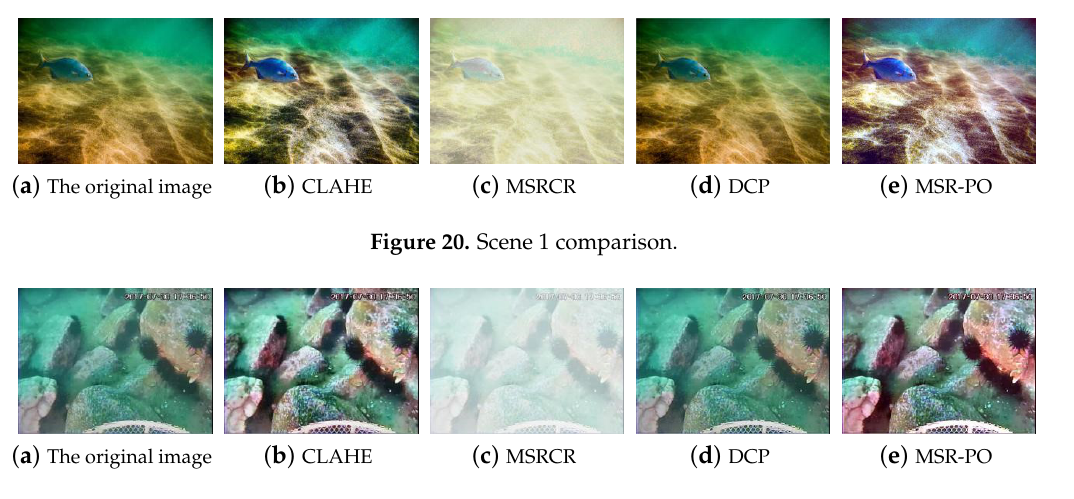
Figure 21. Scene 2